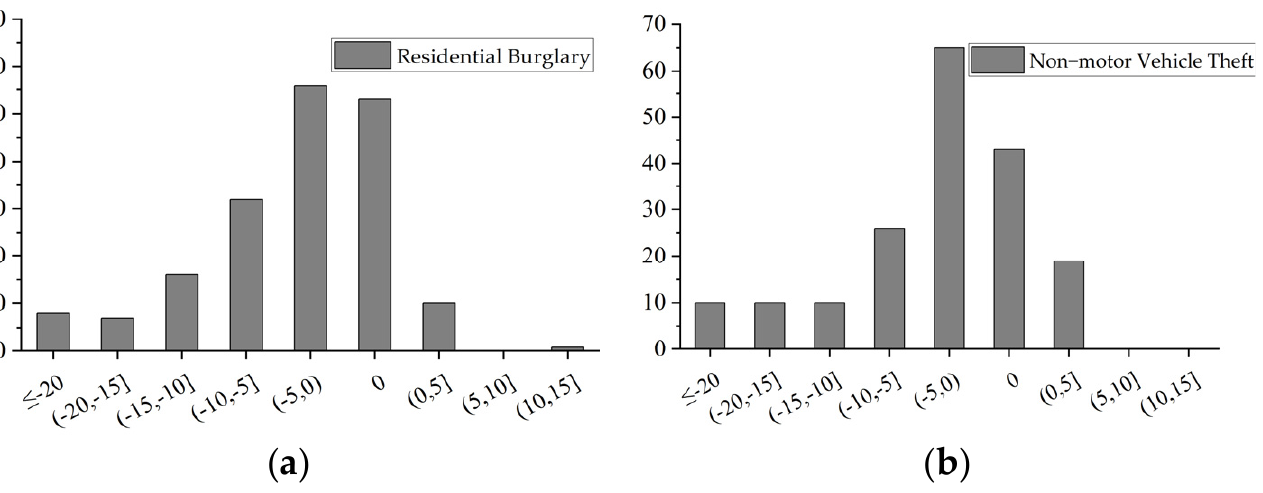
Figure 4. Quantitative variations on residential burglary and non-motor vehicle measured by AJ- PSs during the pre- and pandemic periods. ( a ) Residential burglary, ( b ) Non-motor vehicle theft.